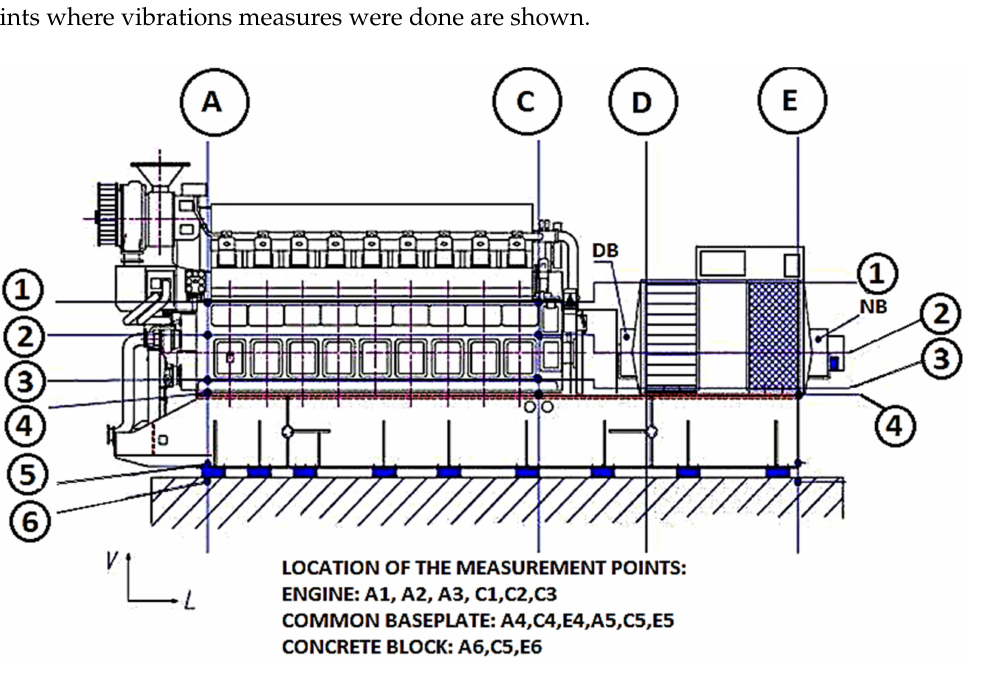
Figure 5. Vibration Analysis: The measuring